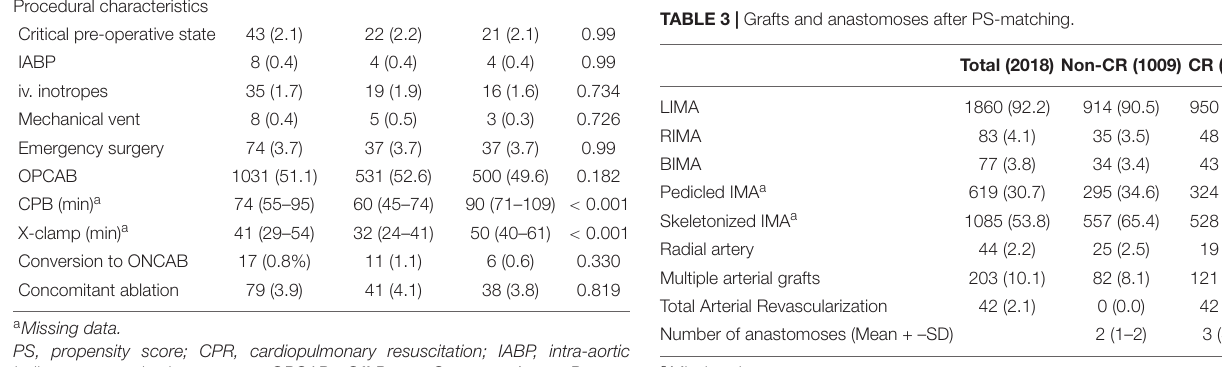
Artery. ± ; SD, Standard